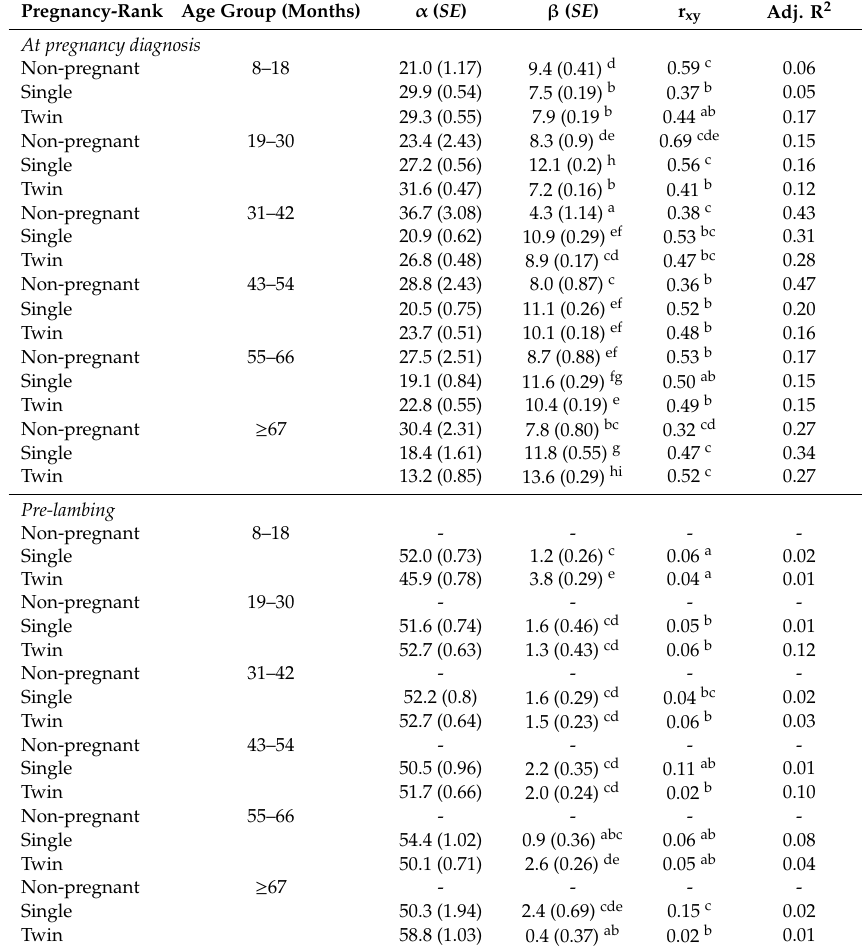
Table 5. Intercepts ( α ), coe ffi cients ( β ), correlation coe ffi cient (r xy ) and adjusted R 2 for the regression of the liveweight with body condition score value for each age (8–18 months, 19–30, 31–42, 43–54, 55–66 and ≥ 67) by pregnancy-rank (non-pregnant, single and twin bearer) and stage of the annual cycle (at pregnancy diagnosis and